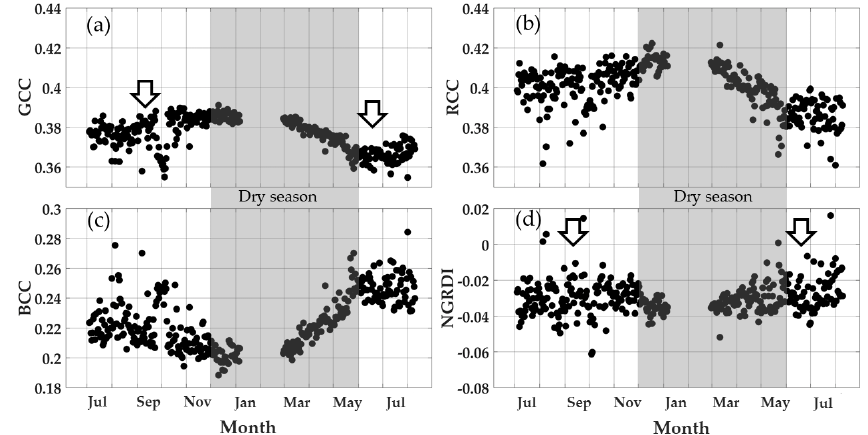
Figure 7. Phenocam-1 RGB color index seasonal profiles of the mangrove forest (ROI 1) from July 2015 to August 2016: ( a ) GCC, ( b ) RCC, ( c ) BCC, and ( d ) NRGDI. Heavy rain from mid-September into October 2015 induced GCC and BCC data spikes. The blank area between January and March 2016 is missing data due to a phenocam malfunction. The arrows indicate new leaf